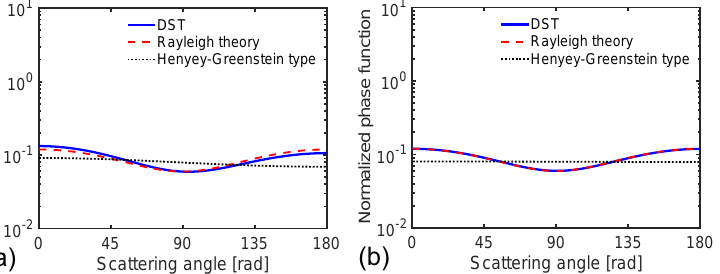
Figure 5. Normalized phase functions calculated from the DST with the scattering angle at different volume fractions of ( a ) 1% ( g = 0.046) and ( b ) 20% ( g = 0.003). The results using the Rayleigh theory and the Henyey–Greenstein type are